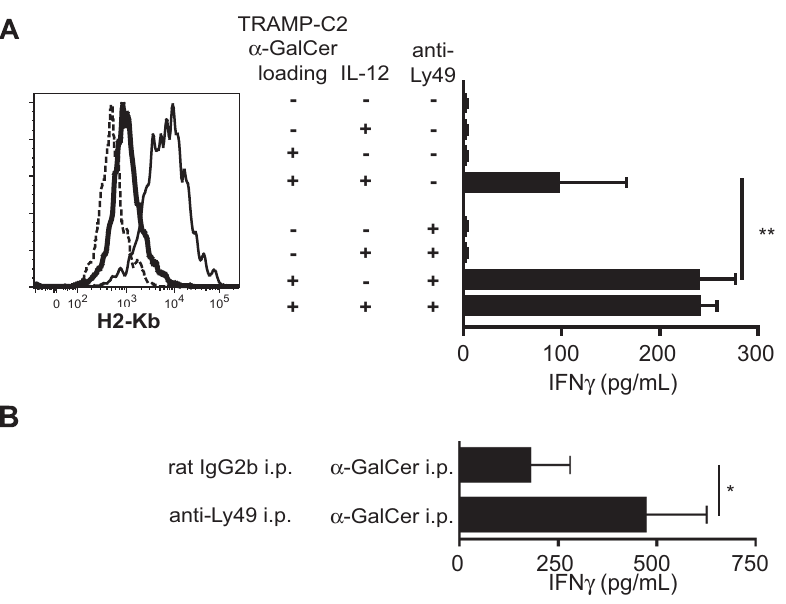
Figure 6. Ly49 blockade concomitant with a -GalCer restores IFN c production in iNKT cells. A. Liver MNC were cultured with a -GalCer loaded or unloaded TRAMP-C2 cells in the presence or absence of exogenous IL-12 and upon blocking with Ly49C/F/H/I molecules on iNKT cells as indicated. Cell culture supernatants were tested for cytokine secretion by ELISA. Histogram shows MHC- (H2-Kb) expression on TRAMP-C2 cells (solid line) or WT C57Bl/6 DC (bold line), isotype controls (dashed line). B. Tumor-bearing TRAMP mice were i.p. injected with each 50 uG anti-Ly49C/F/H/I mAbs 18 h and 2 hours before 2 m G a -GalCer was injected i.p. Graphs shows IFN c serum levels (n=3, p , 0.05).